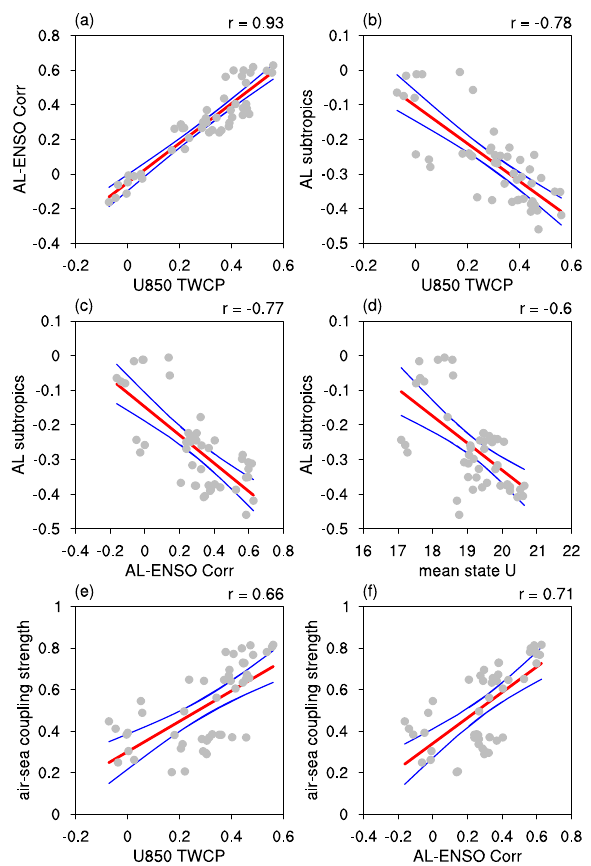
Fig. 4 Factors contribute to enhanced impact of AL on ENSO. Scatter plots of the Mar(0) ALI-related 850-hPa winds anomalies in AM(0) averaged over tropical western-central Paci fi c (TWCP, box in Fig. 2b) for 23-year running period against a the 23-year running correlations between the Mar(0) ALI and D(0)JF( + 1) Niño-3.4 SST index, and against b the Mar(0) SLP anomalies averaged over